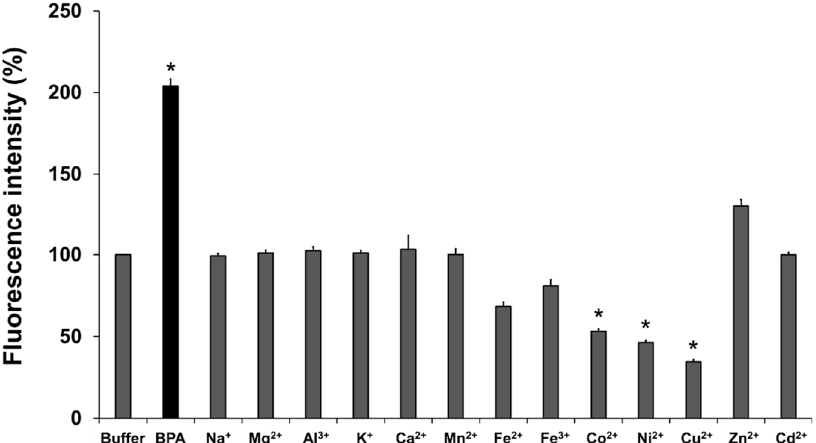
Figure 5. BITQ fluorescence intensity (1.0 µ M) 15 min after adding BPA or metal cation (100 µ M, pH Figure 5. BITQ fl uorescence intensity (1.0 µM) 15 min after adding BPA or metal cation (100 µM, pH 7.4) with buffer-only sample as a standard (100%). * p < 0.05 vs. buffer (0.5% DMSO/Tris HCl buffer 7.4) with bu ff er-only sample as a standard (100%). * p < 0.05 vs. bu ff er (0.5% DMSO/Tris HCl bu ff er only) by Dunn’s multiple comparison only) by Dunn’s multiple comparison test.